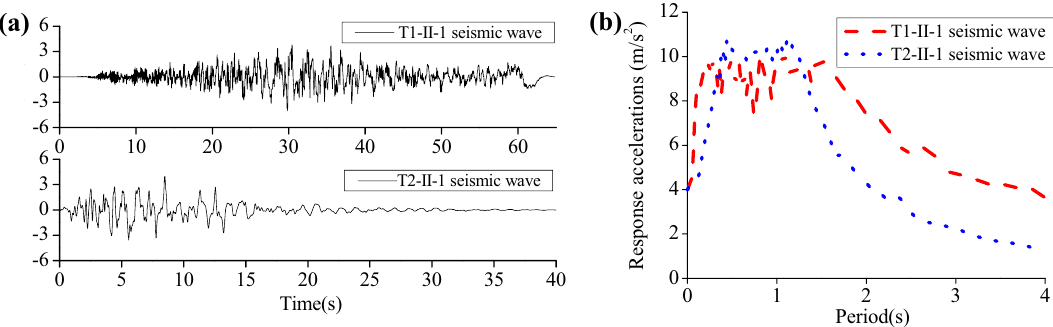
Figure 3. Seismic waves and its response spectrum: ( a ) acceleration time histories; ( b ) response spectrum.